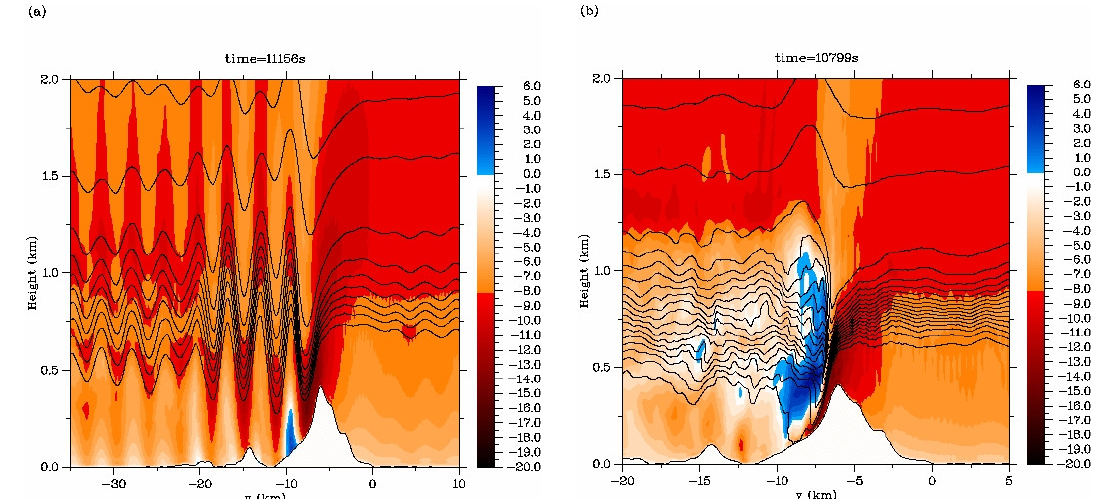
Figure 3. Vertical cross-sections of cross-ridge wind and potential temperature through two idealised 3-D simulations of northerly flow over East Falkland in ( a ) “Type 1” and ( b ) “Type 2” rotor flows. The wind component is shaded (units are m s −1 ) and potential temperature contoured every 1 K. Flow is from the right. Reproduced from Reference [53].